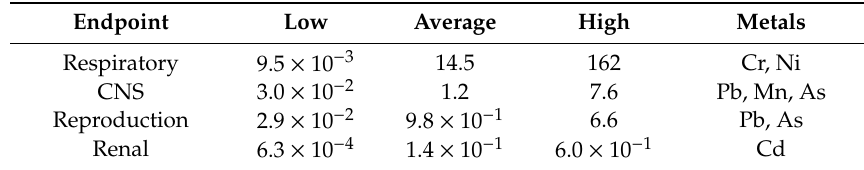
Table 5. Non-cancer HI (summed) for the target organs * from estimated exposure to metals in e-cigarette aerosols (CalEPA RELs and